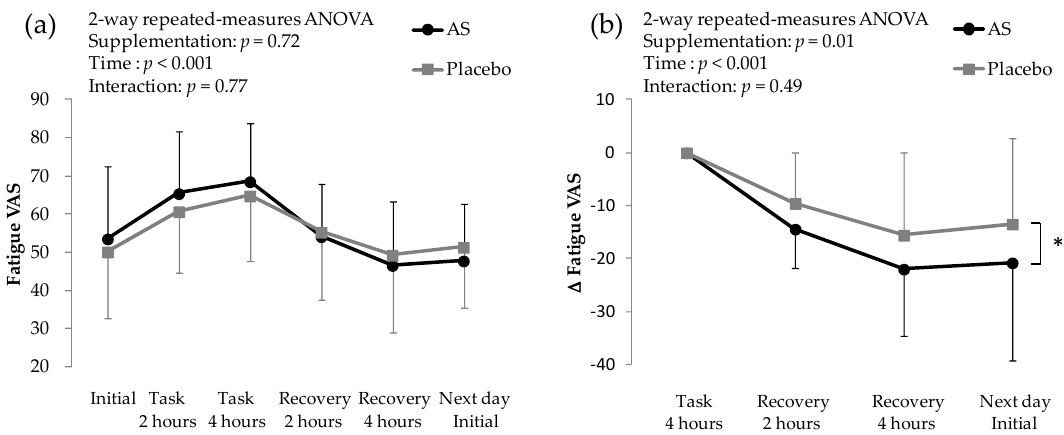
Figure 3. Subjective fatigue evaluated with VAS on mental task day. ( a ) VAS scores on mental task day; ( b ) Difference in VAS scores in recovery period. * p < 0.05 between AS and placebo by 2-way repeated-measures ANOVA. Data are presented as the means ± S.D.